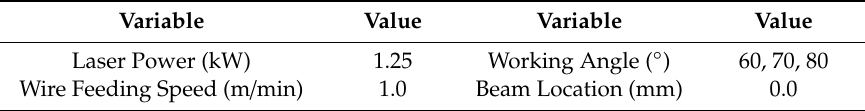
Table 5. Welding conditions of Step 1 (working angle change, 3